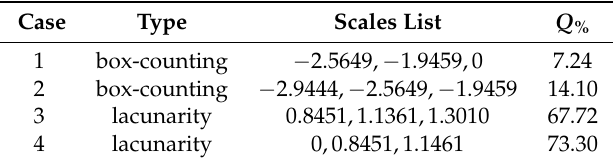
Table 1. Configuration of multi-parameter methods and obtained results.